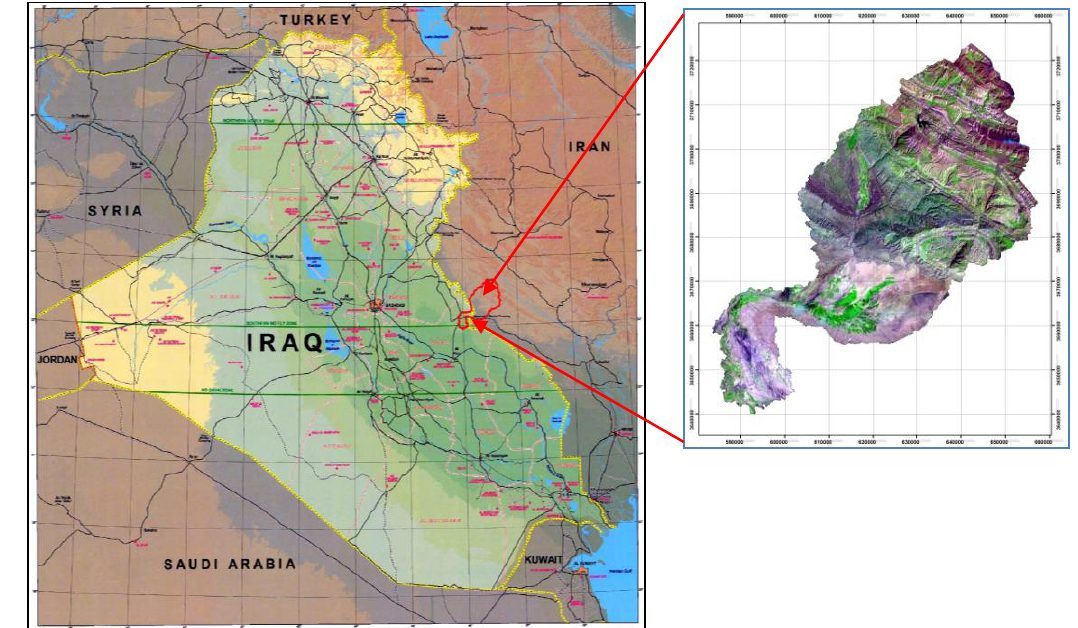
Fig. 1: Location of the study